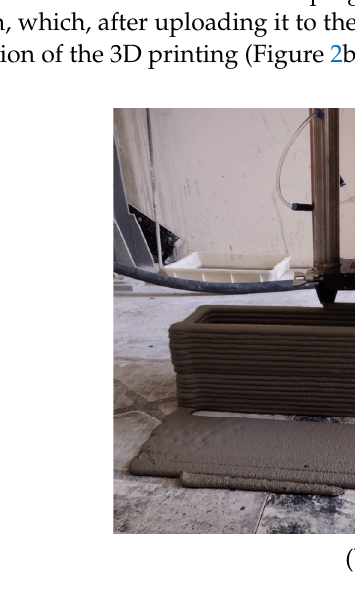
Figure 2. ( a ) Preparing the print in the StarSlicer program; ( b ) 3D printing of the object on TestBed.